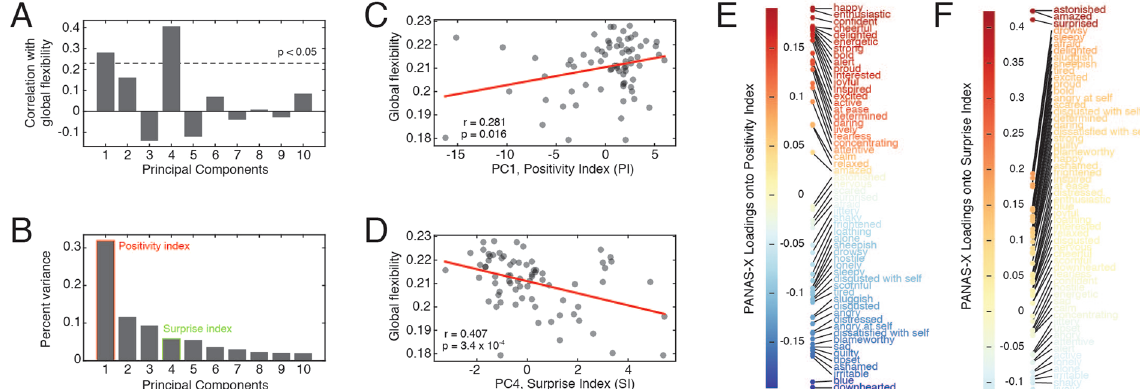
Figure 3. Relationship of global flexibility to principal components. ( A ) Correlation of first ten principle components with global flexibility. ( B ) Percent variance accounted for by each of said components. ( C ) Scatterplot highlighting relationship of the first principal component (PC1) with global flexibility. ( D ) Scatterplot highlighting relationship of the fourth principal component (PC4) with global flexibility. ( E ) Detail of the positivity index (PC1). Each colored point indicates the loading of a PANAS-X category onto the first principal component, which we termed the “positivity index”. ( F ) Detail of the surprise index (PC1). Each colored point indicates the loading of a PANAS-X category onto the fourth principal component, which we termed the “surprise index”. Note: In panel (A) the correlation of PC4 and flexibility was positive. For ease of interpretation, we flipped the sign of PC4 and the loadings of PANAS-X terms onto that component. In effect, this only changes the sign of the correlation; not its